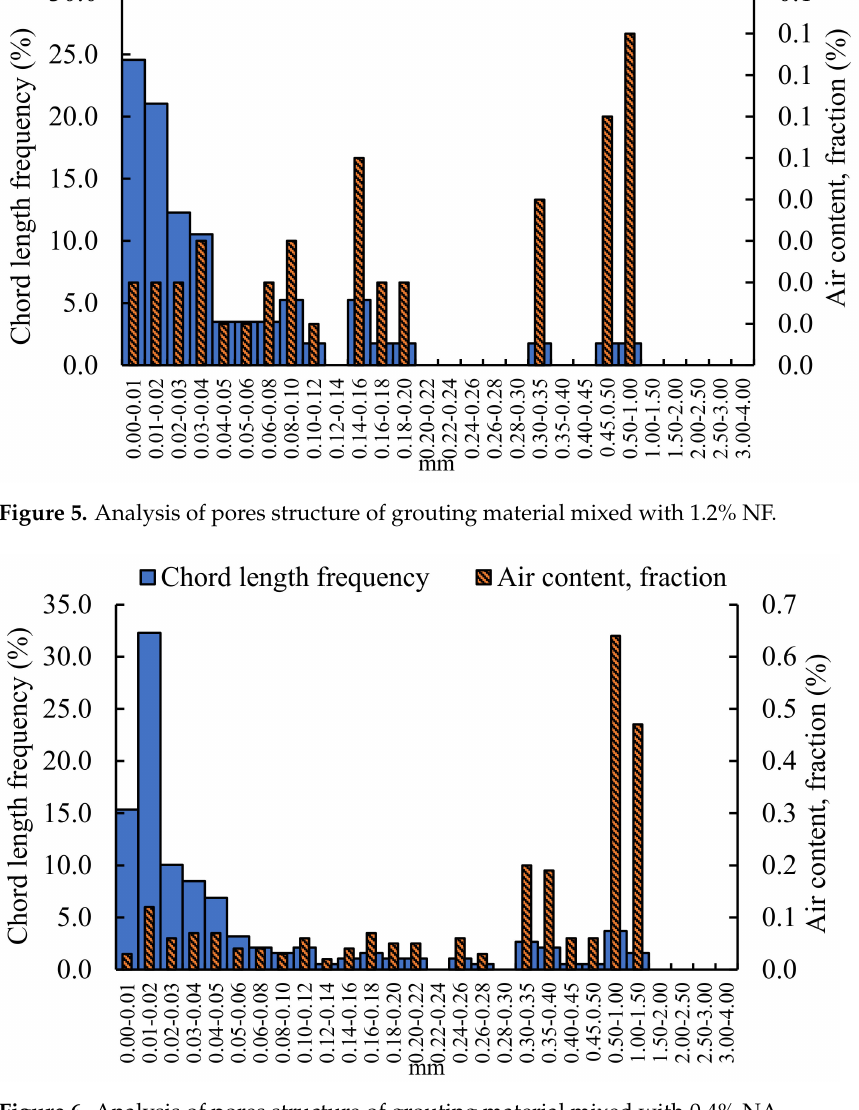
Figure 6. Analysis of pores structure of grouting material mixed with 0.4%